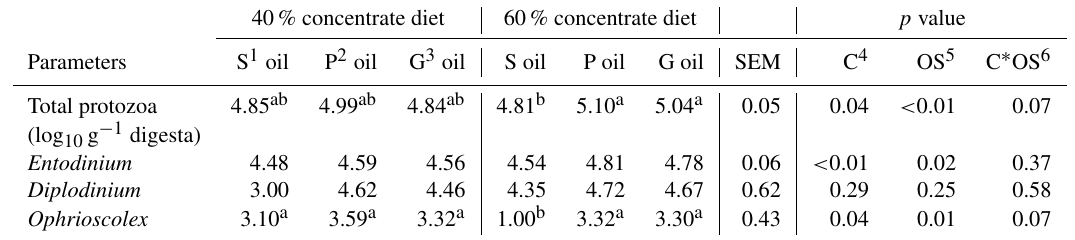
Table 4. The effect of sunflower, pomegranate and garlic oil on protozoal counts in diets containing 40% or 60%